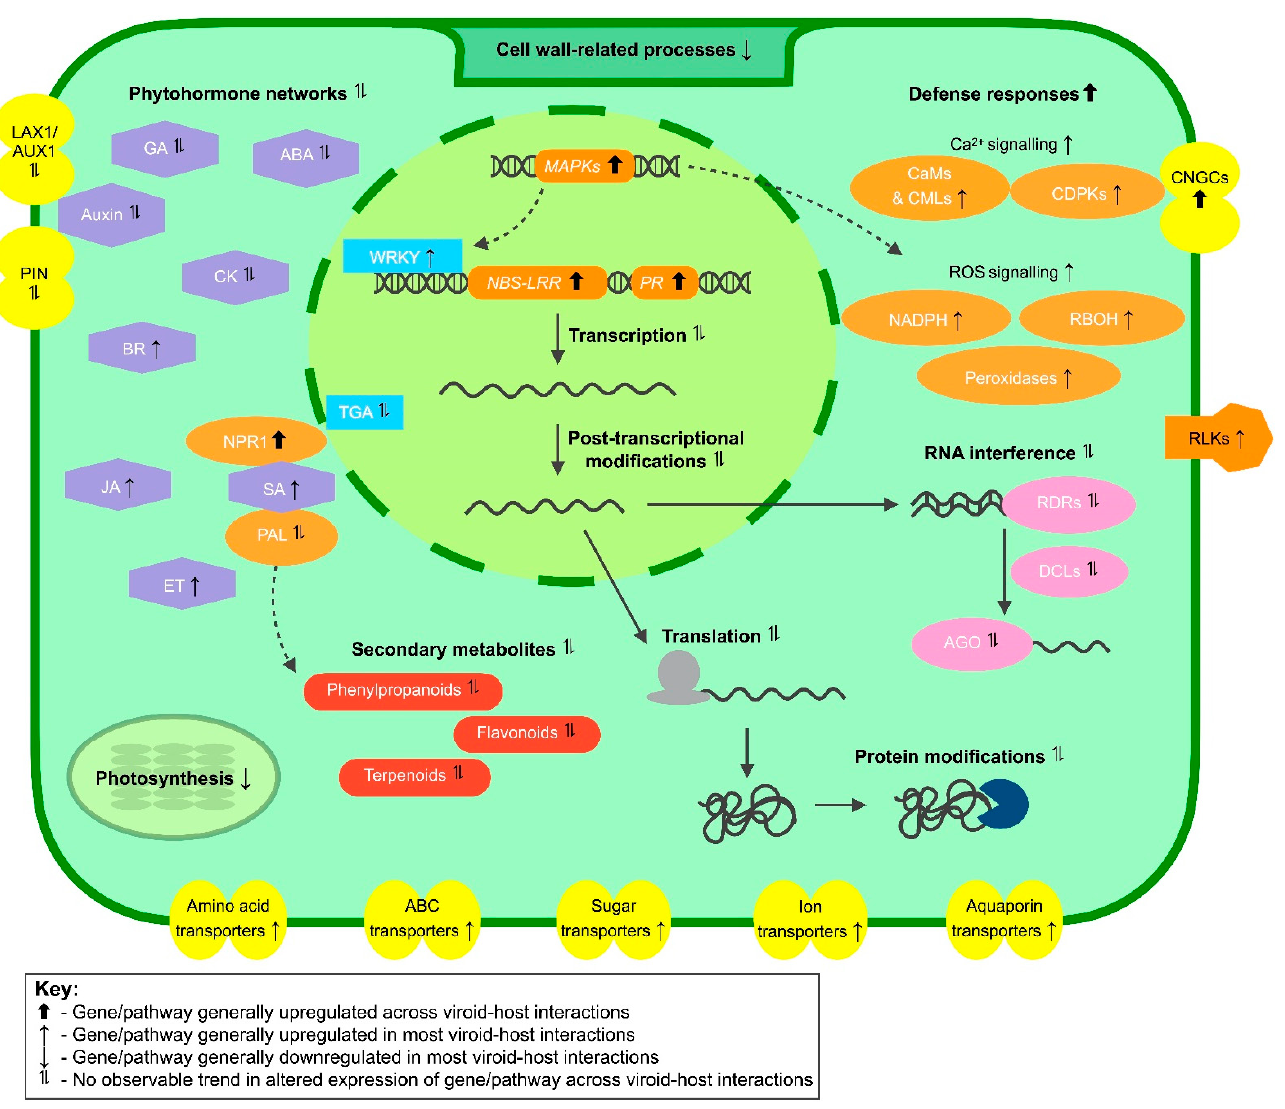
Figure 1. Signalling pathways and cellular components with altered gene expression after viroid infection. Transcriptome studies revealed that several functionally distinct gene groups were commonly affected in viroid–host interactions. Affected gene networks included those involved in plant immunity ( orange boxes ), phytohormone signalling ( purple boxes ), transport ( yellow boxes ), production of secondary metabolites ( red boxes ), cell wall modification and photosynthesis. Gene expression pathways were also affected, with components functioning in transcription ( light blue boxes ), post-transcriptional gene silencing ( pink boxes ), translation and protein modification commonly had altered expression profiles in viroid–host interactions. General trends in gene expression, based on available transcriptomic data, are indicated by the direction of arrows for each network/cellular component.